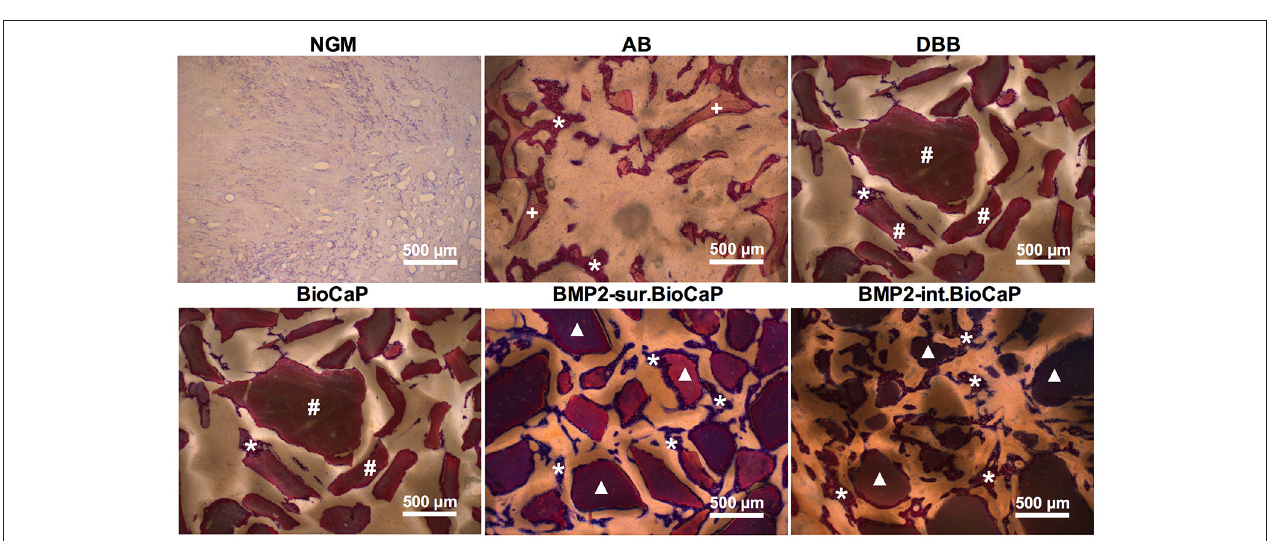
FIGURE 6 | Histological images in higher magnification showing newly formed bone and grafted biomaterials in the defect site after 4 weeks of grafting. White stars: remaining graft materials; + : remaining autologous bone; #: remaining DBB.